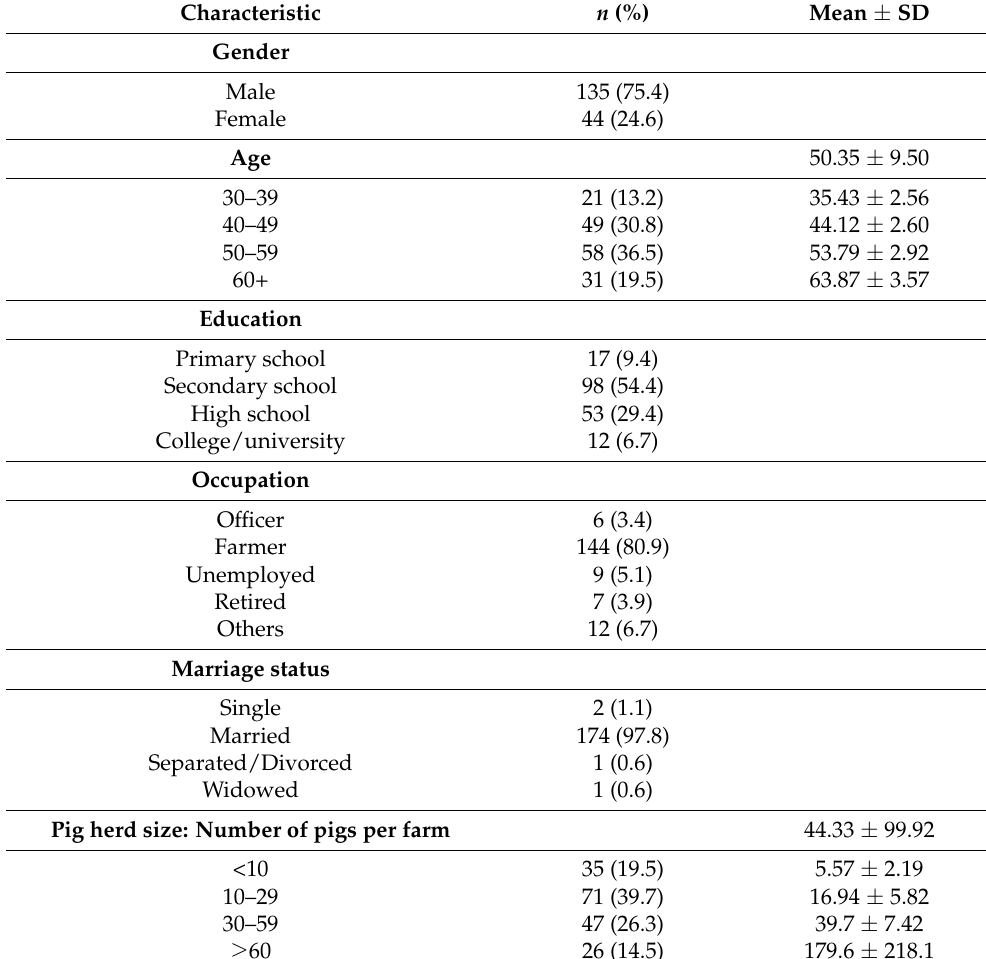
Table 1. Social-demographic features of pig